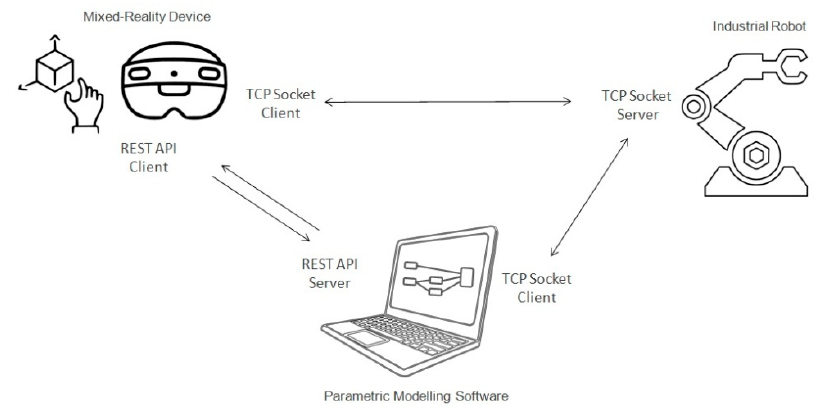
Figure 4. Communication diagram between the parametric-modeling software, the mixed-reality device, and the industrial robot.